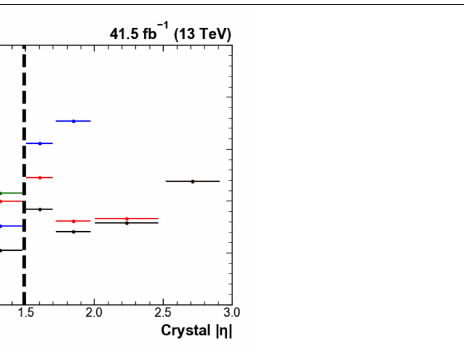
Figure 3. Residual mis-calibration of the ECAL channel inter-calibration, as a function of pseudo- rapidity using the full 2017 dataset, obtained with three di ff erent methods (green, blue, red dots), and combining the three methods (black).